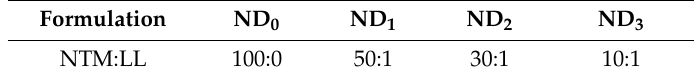
Table 1. Composition of netilmicin (NTM) dry powder inhalations (DPIs).